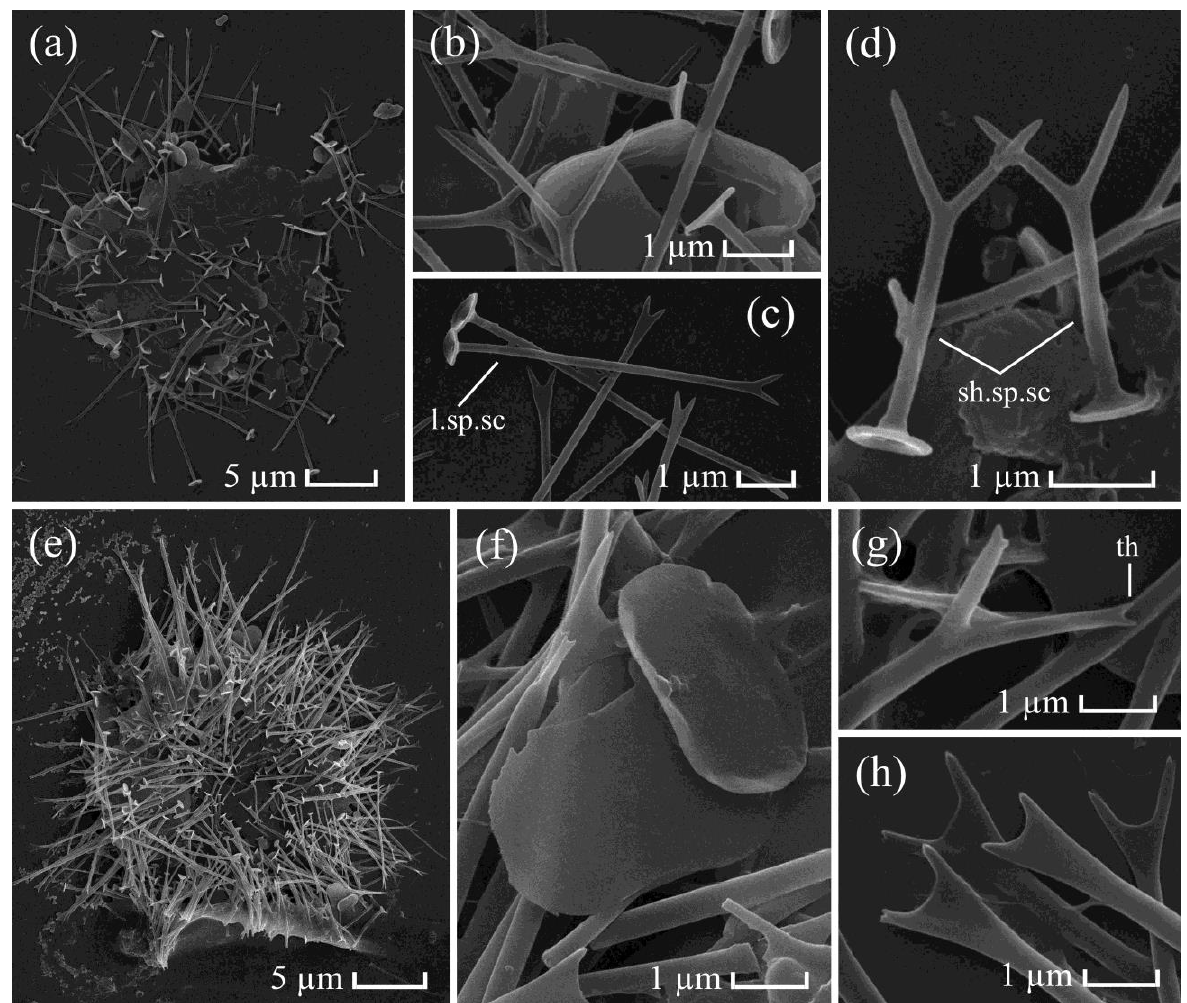
Figure 3. Morphology of observed scales of centrohelid species Acanthocystis turfacea , SEM. (a)–(d) A. turfacea “ viridis ”: (a) scales of single cell; (b) short spine scales and plate scales; (c) long spine scales; (d) short spine scales. (e)–(h) A. turfacea “ gigas ”: (e) scales of single cell; (f) plate scales; (g) tip of short spine scale; (h) tips of long spine scales. Abbreviations: l.sp.sc = long spine scales; sh.sp.sc = short spine scales; th =